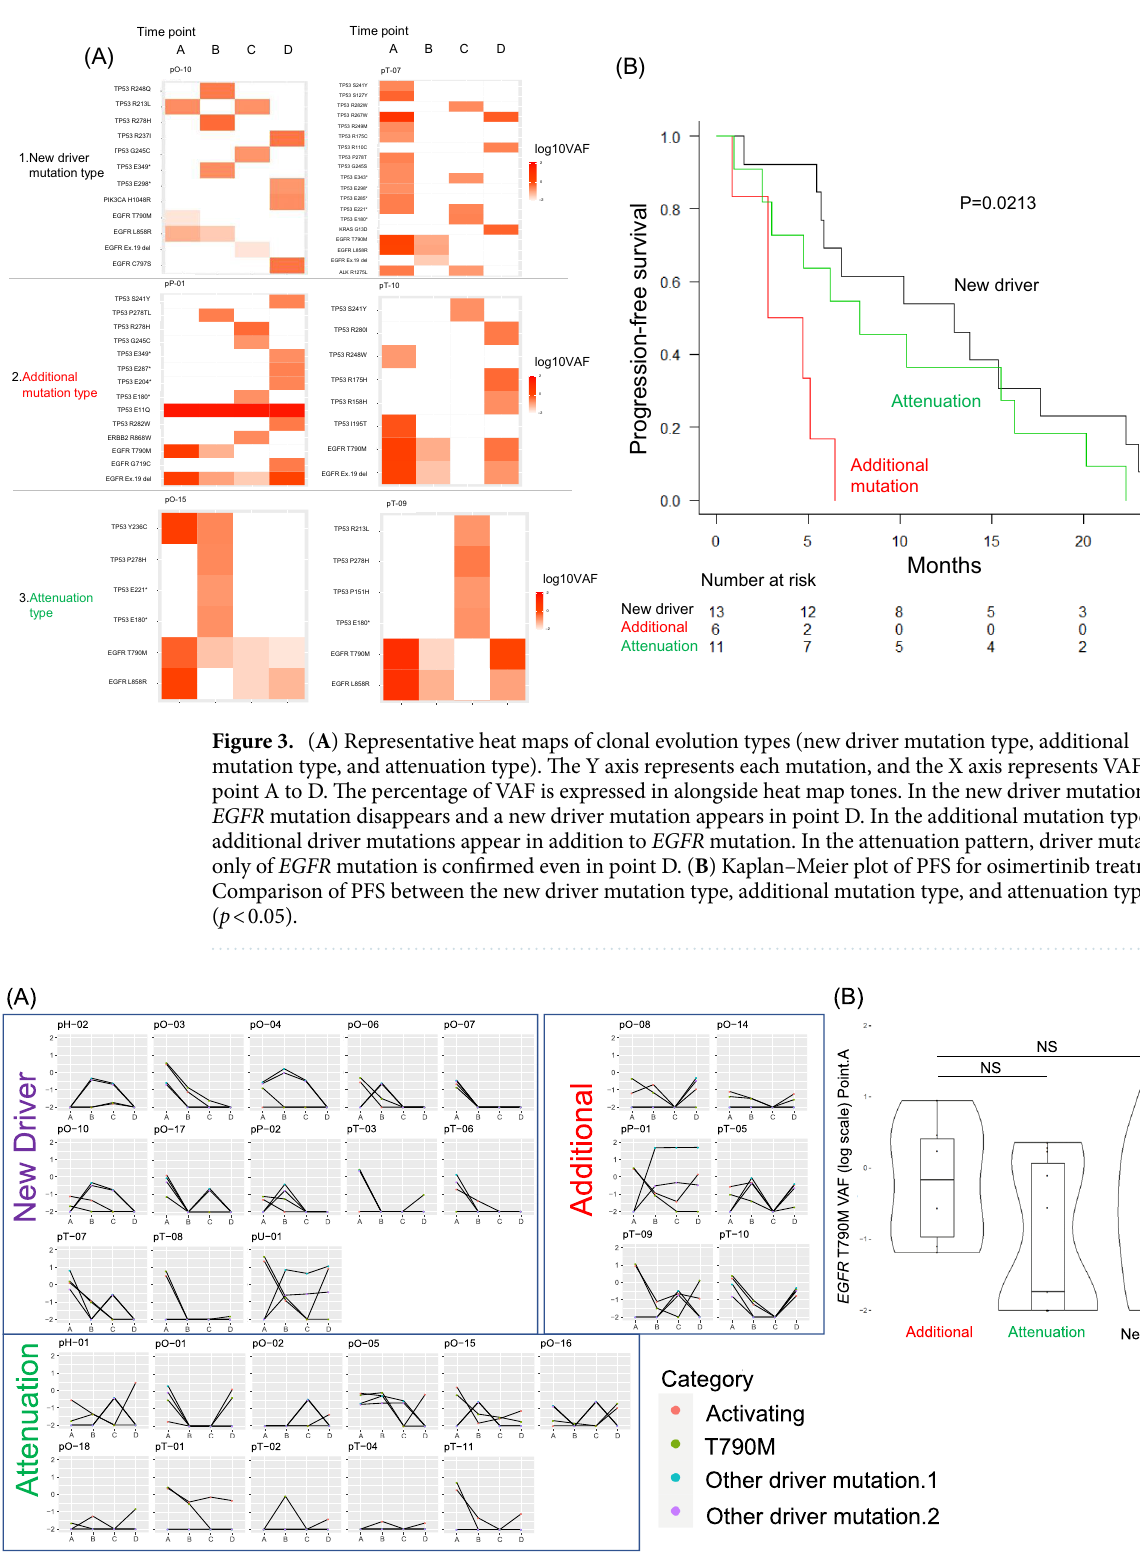
Figure 4. ( A ) Graphical plot of the variation of VAF for EGFR major mutation, T790M mutation, and other driver mutations for the 30 cases, for which samples were collected from points A to D. It is divided into three types according to the evolutional pattern: new driver, additional driver, and attenuation patterns. ( B ) Comparison of the VAF of EGFR T790M at Point A between the new driver, additional driver, and attenuation patterns. NS; no